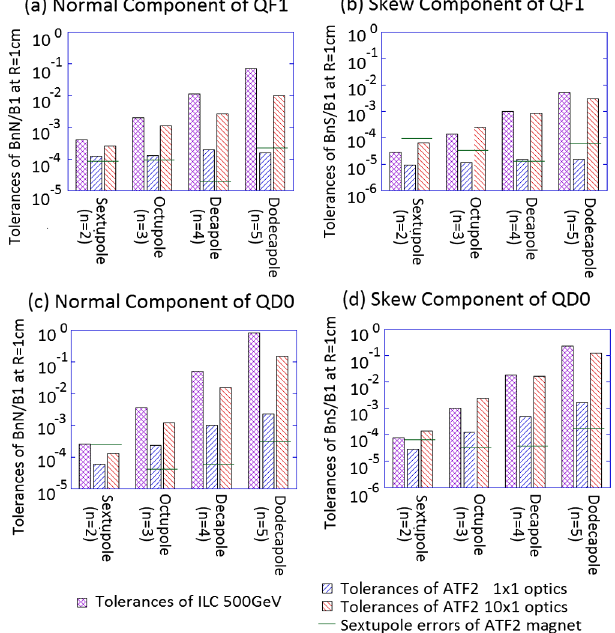
(QF1 and QD0) of the ILC and ATF2 final focus beam lines. The tolerances are defined as the error of each component required to induce a 2% IP vertical beam size growth. The multipole field errors in the ATF2 magnets are also plotted. Since the bore radius of the ATF2 final doublet magnets are much larger than ILC, the multipole fields of the ATF2 final doublet are measured at R ¼ 2 cm and scaled to R ¼ 1 cm.